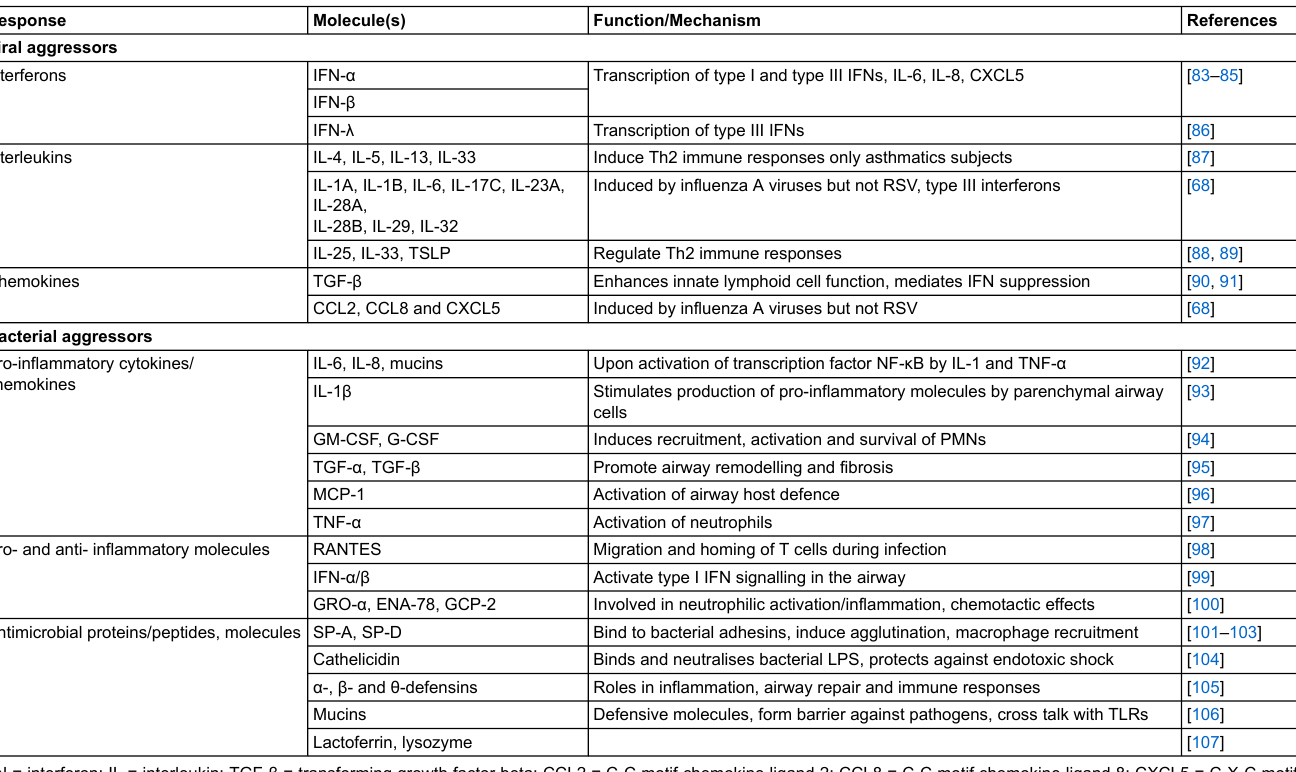
Table 3: Defence reaction of respiratory cells to viral and bacterial